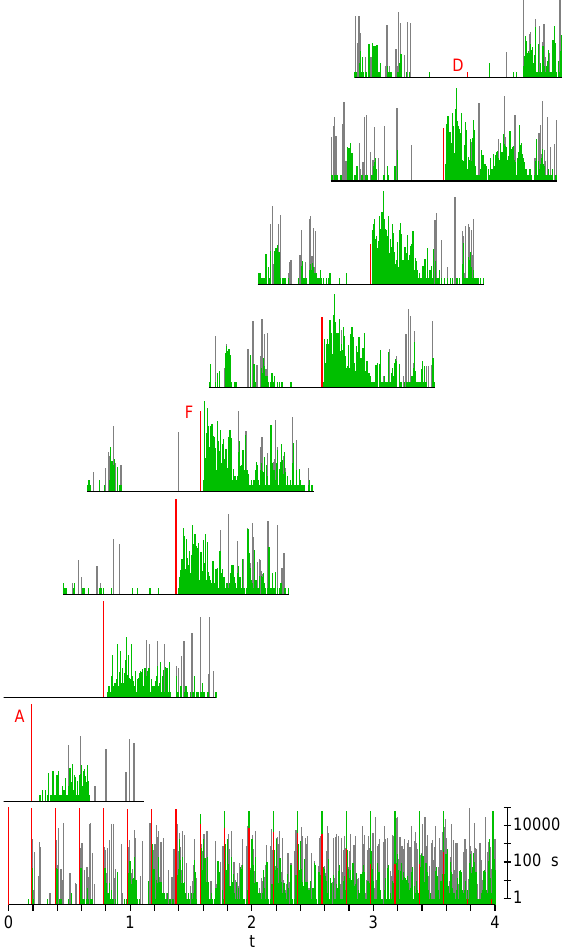
Fig. 5. A sequence of events computed on a 512 × 512 grid, starting from a large event spanning 37% of the grid. Only events over- lapping the rupture area of the initial event are plotted. Red bars: Events starting from the same hypocenter as the first one. Green bars: Events starting from hypocenters within the rupture area of the first event. Grey bars: Events starting from outside the rupture area of the first event. The upper plots are parts of the sequence around selected events where the time axis is nonlinearly stretched √ t − t redbar according to t stretched = t redbar + 2 3